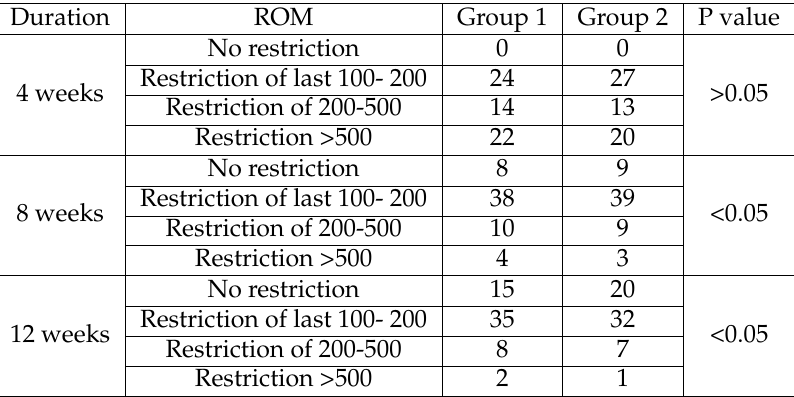
Table 2. Post- operative range of motion in both groups.